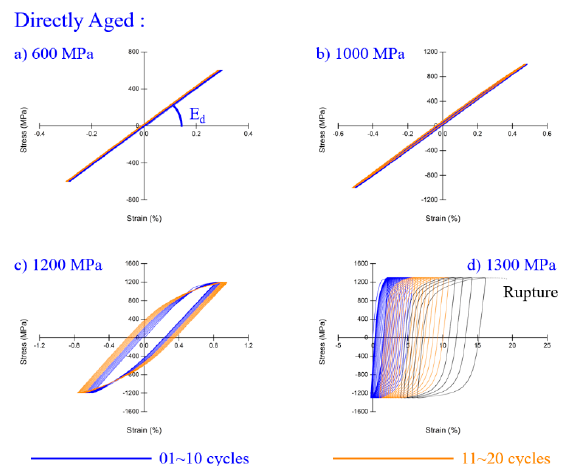
Figure 6. Hysteresis loop of aged Inconel 718 ( σ 0.2 = 1249 MPa): at ( a ) 600 MPa; ( b ) 1000 MPa; ( c ) 1200 MPa; ( d ) 1300 MPa.